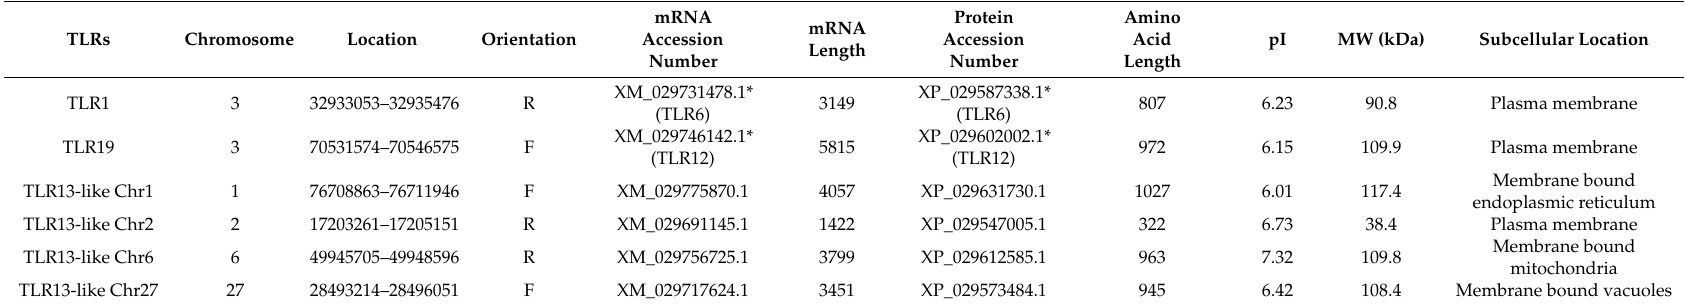
Table 1. Characteristics of Toll-like receptors (TLRs) of brown trout used in the present study. The chromosome number, location, transcriptional direction (F–forward and R–reverse), NCBI accession numbers, length of mRNA, and the amino acid sequences of each TLR are provided. The details of the predicted isoelectric point (pI), molecular weight (MW), and subcellular location are also